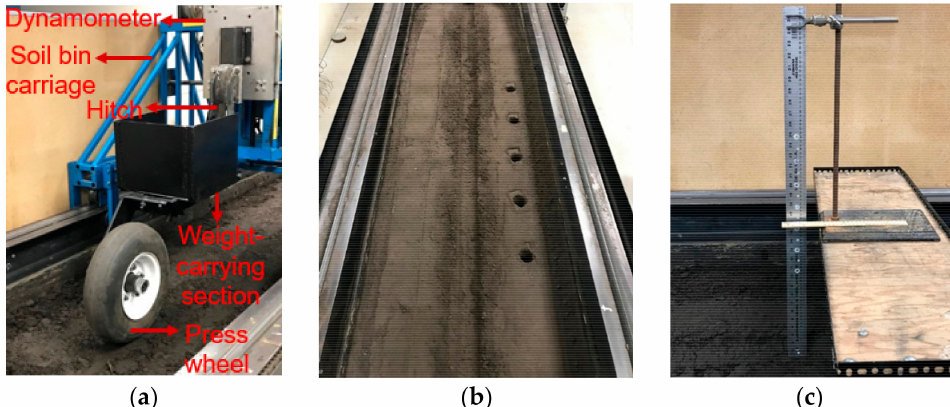
Figure 1. ( a ) Press-wheel, test apparatus and soil bin; ( b ) Soil sinkage resulting from the press-wheel and collection of soil bulk density samples; ( c ) Measurement of soil surface elevation before and after a test